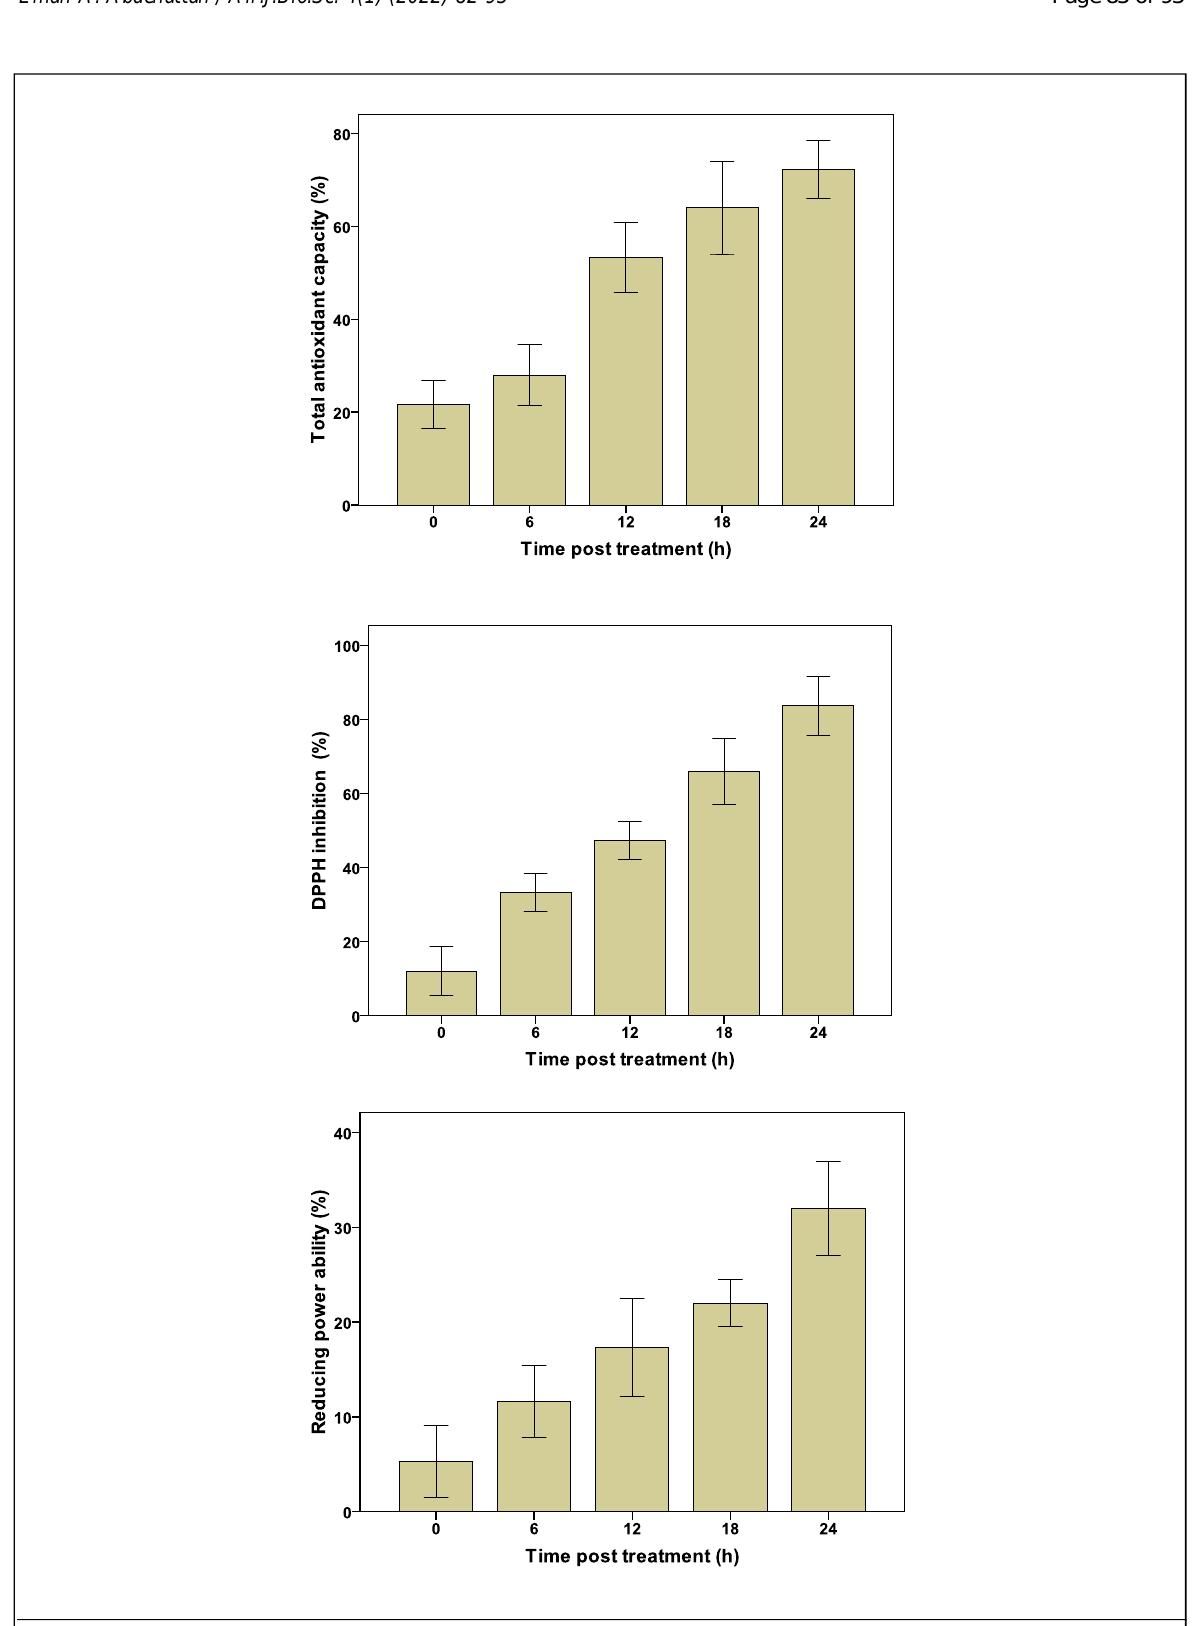
Figure 1: Effects of different concentration of commercial vitamin B12 on the (mean, P25, P75) of total antioxidant capacity, reducing power, and 2,2 diphenyl-1-picylhydrazyl (DPPH) measured in adult of Sitophilus oryzae . Adult insects were injected with different time course post injection of vitamin B12: 0, 6, 12, 18 and 24 h. ‘small letter’ at the top of the fig. report the statistical comparisons among control and vitamin B12-treated larvae at each case separately (ANOVA, Tukey2 s-b test, p <